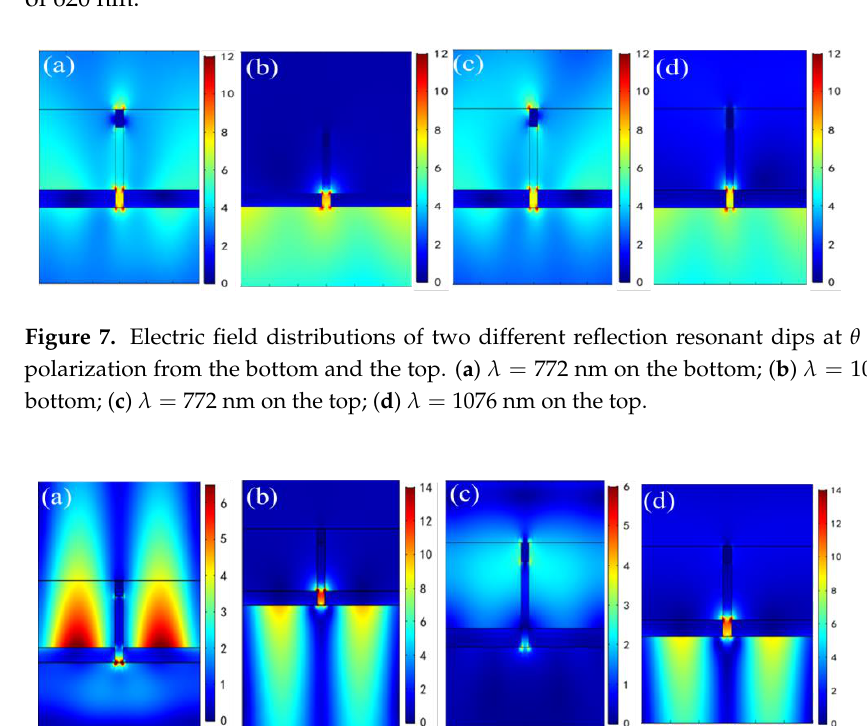
Figure 8. Electric field distributions of two different reflection resonant dips at θ = 0 ◦ for TM polarization from the bottom and the top. ( a ) λ = 620 nm on the bottom; ( b ) λ = 916 nm on the bottom; ( c ) λ = 620 nm on the top; ( d ) λ = 916 nm on the top. Similarly, the RI response of the little dip between the first dip and the second